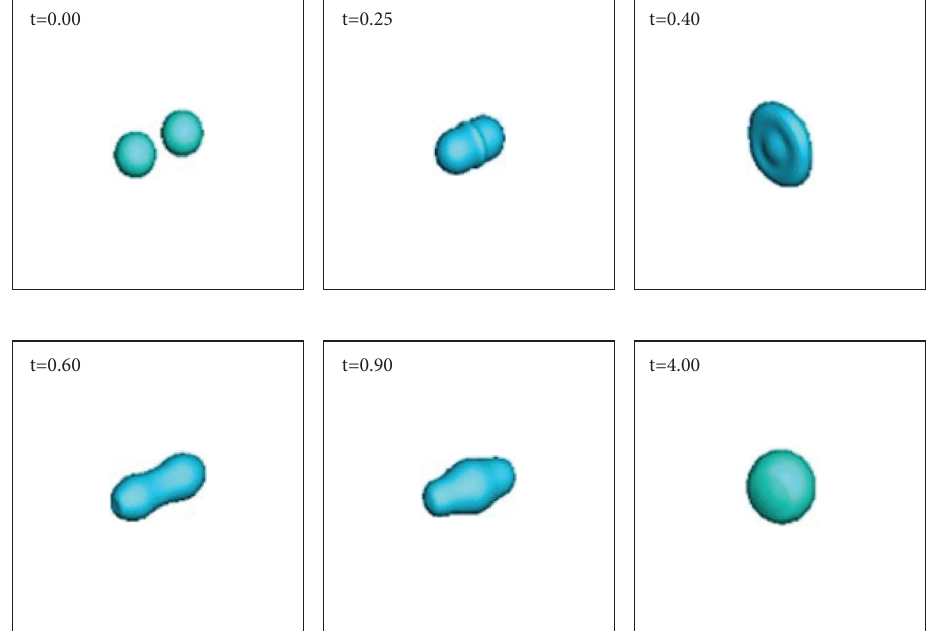
Figure 4: Simulation of droplet deformation process with a simulated droplet diameter of 200 μ m and an initial collision velocity of